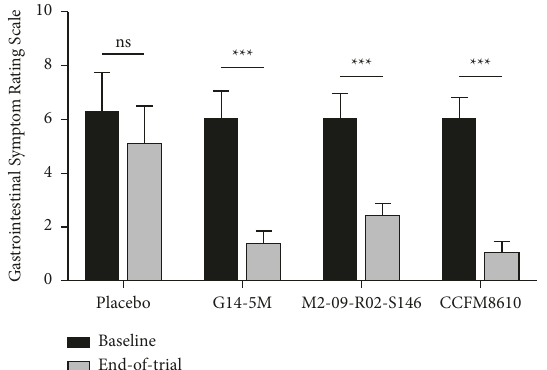
Figure 3: Gastrointestinal symptom rating scale scores of the three treatment groups at baseline and at